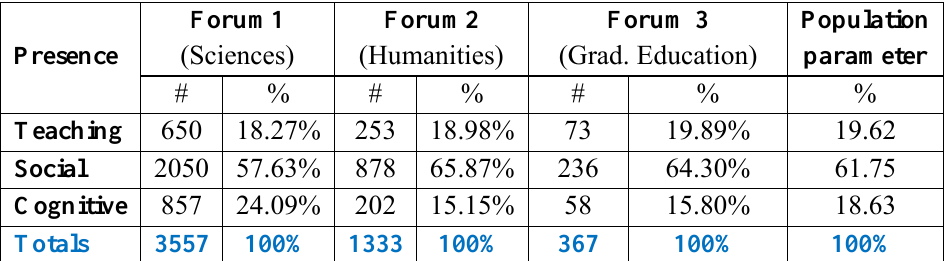
Comparing a Graduate Education Course with the Estimated Population Parameter and with the Composite Science and Humanities